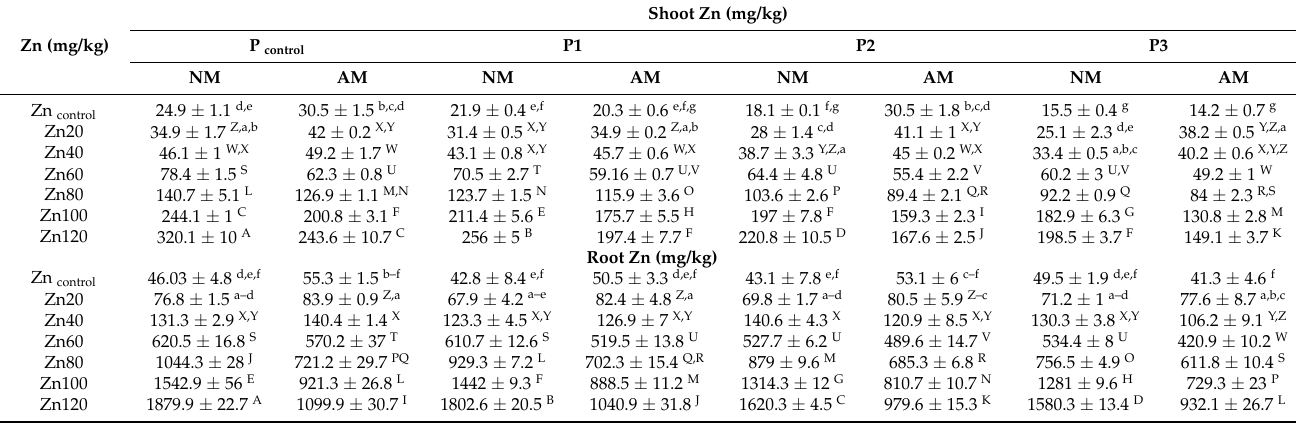
Mean values are presented ± standard error (SE). Different letters show significant difference at p ≤ 0.05. Capital letters indicate the highest values. After completely using upper case letters up to Z, lower case letters are used to show the decrease of mean values. AMF